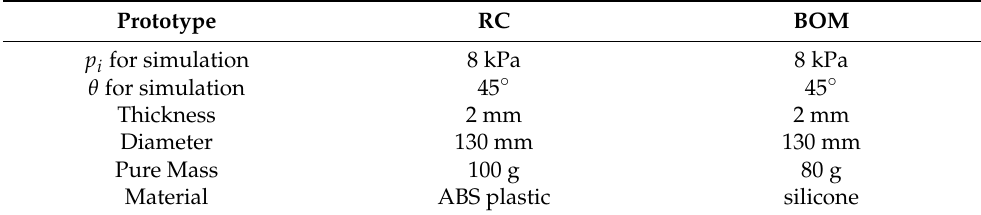
Table 1. Basic parameter of the connecting plate in the